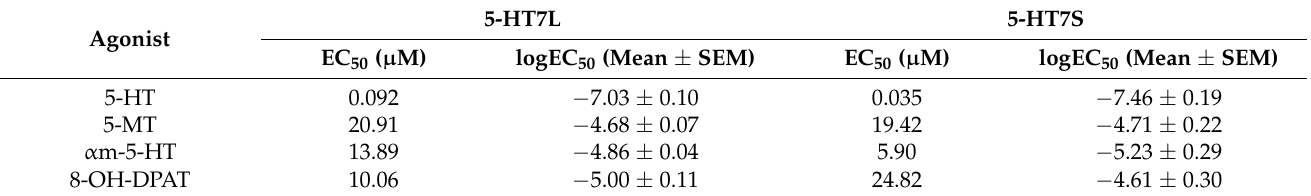
Table 1. EC 50 values of agonists to activation of two Msep5-HT7 receptor isoforms in HEK-293